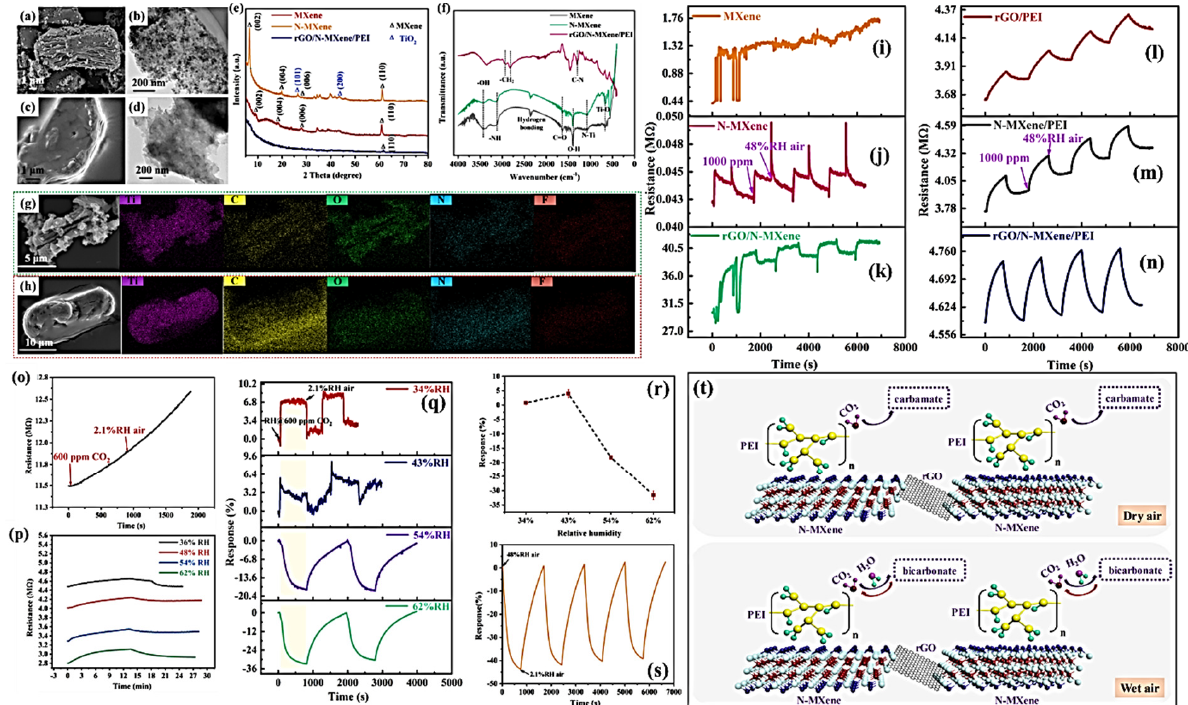
Figure 19. ( a ) SEM image of N-MXene; ( b ) TEM image of N-MXene; ( c ) SEM image of rGO/N-MXene/PEI composites; ( d ) TEM image of rGO/N-MXene/PEI composites; ( e ) XRD spectra; ( f ) FTIR study of MXene, N-MXene, and rGO/N-MXene/PEI hybrid; ( g ) elemental mapping of N-MXene and ( h ) rGO/N-MXene/PEI nanocomposites; resistance transients of sensors ( i ) MXene, ( j ) N-MXene, ( k ) rGO/N-MXene, ( l ) rGO/PEI, ( m ) N-MXene/PEI, and ( n ) rGO/N-MXene/PEI sensors for 1000 CO 2 in 48% (relative humidity) RH air at room temperature (20 °C); ( o ) dry and ( p ) humidified dynamic resistance of the composite (ternary) sensor at 20 °C under 600 ppm CO 2 ; sensing performance of the ternary sensor: ( q ) Response toward a mixture of 600 ppm CO 2 and under varying RH, response as a function of RH obtained from ( r – t ) response to pure 48% RH at 20 °C and schematic representation of the CO 2 sensing mechanism of rGO/N-MXene/PEI sensors under dry and wet air respectively. Reproduced with permission from [164].